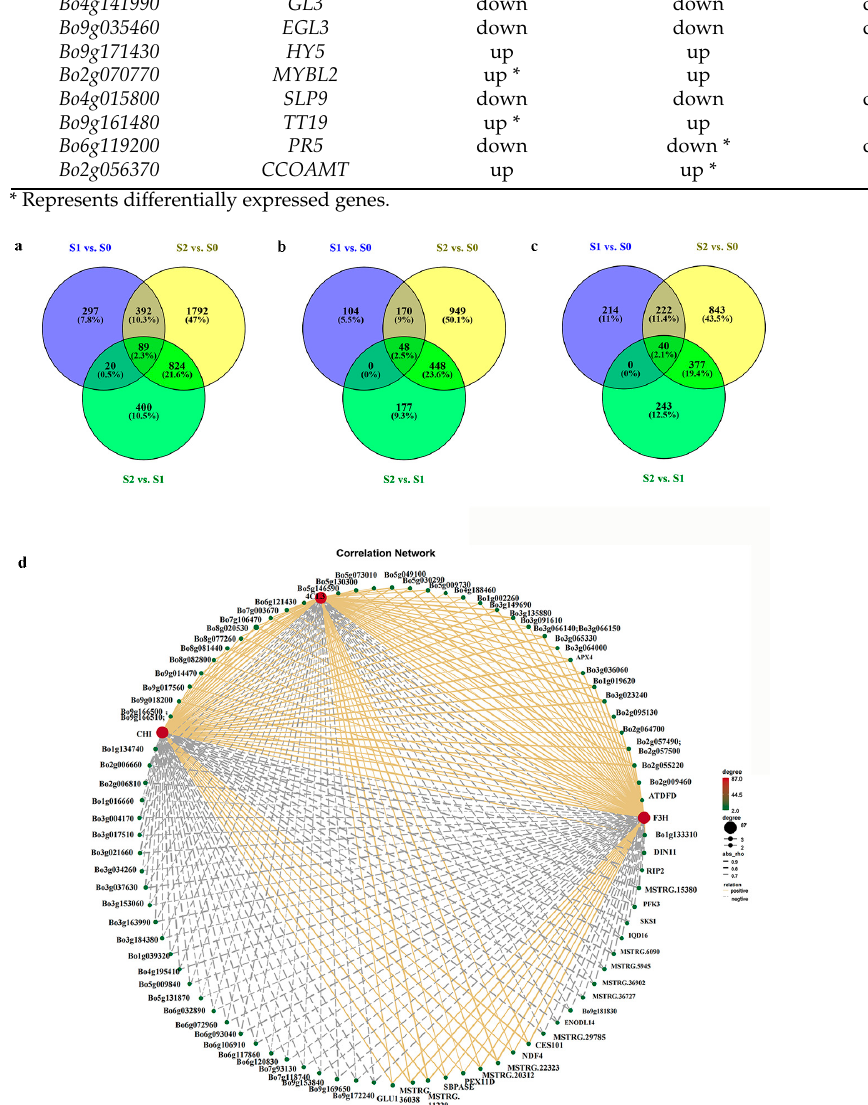
Figure 8. Co-expressed genes in the three development stages. ( a ) Co-expressed genes in the three comparisons; ( b ) Co-expressed upregulated DEGs in the three comparisons; ( c ) Co-expressed downregulated DEGs in the three comparisons; ( d ) The correlation network of co-expressed DEGs.